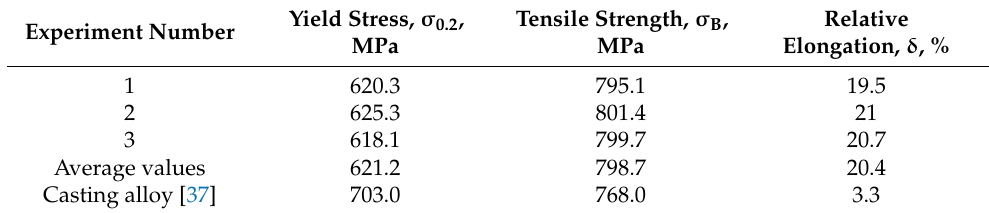
Table 9. Mechanical properties of cylindrical